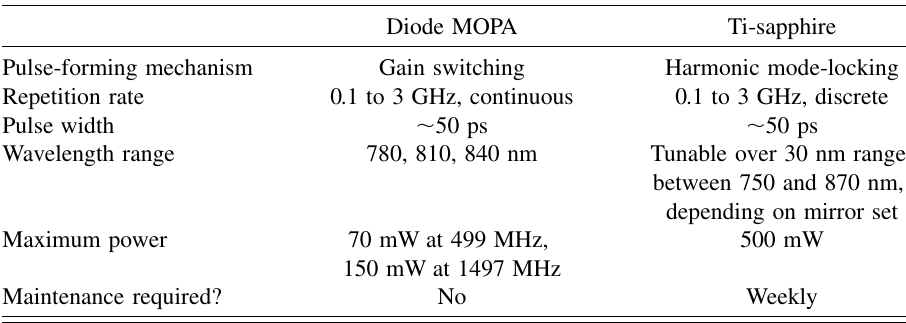
TABLE II. A comparison of features for the diode MOPA and mode-locked Ti:sapphire drive lasers developed for CEBAF.